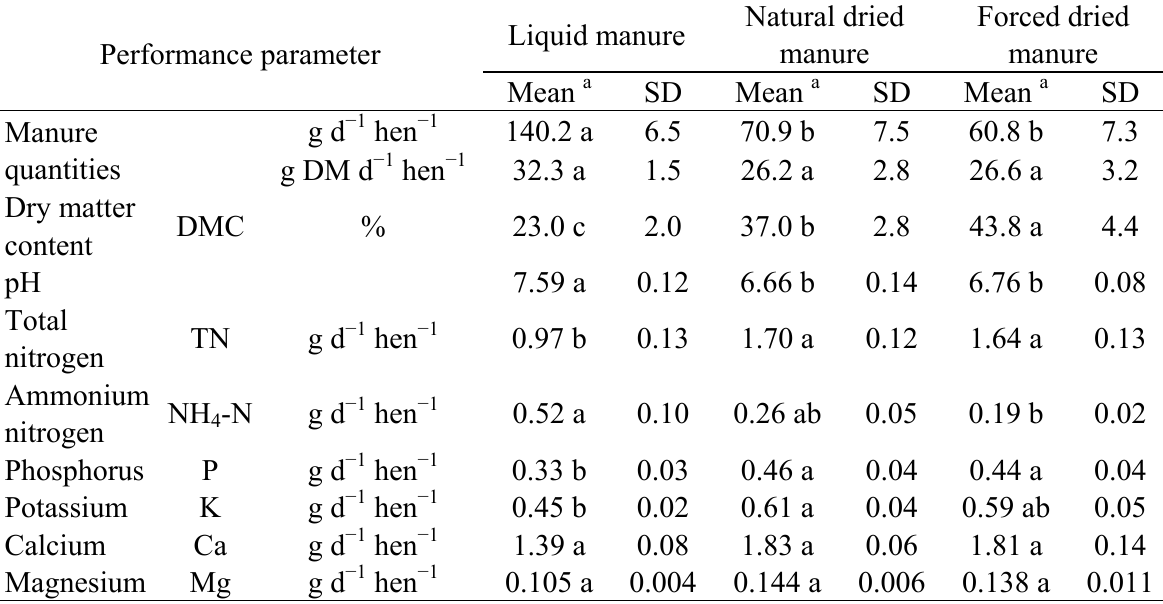
Table 3. Composition of the manure collected in the deep pit (liquid manure) and on the manure belts (natural or forced dried manures).